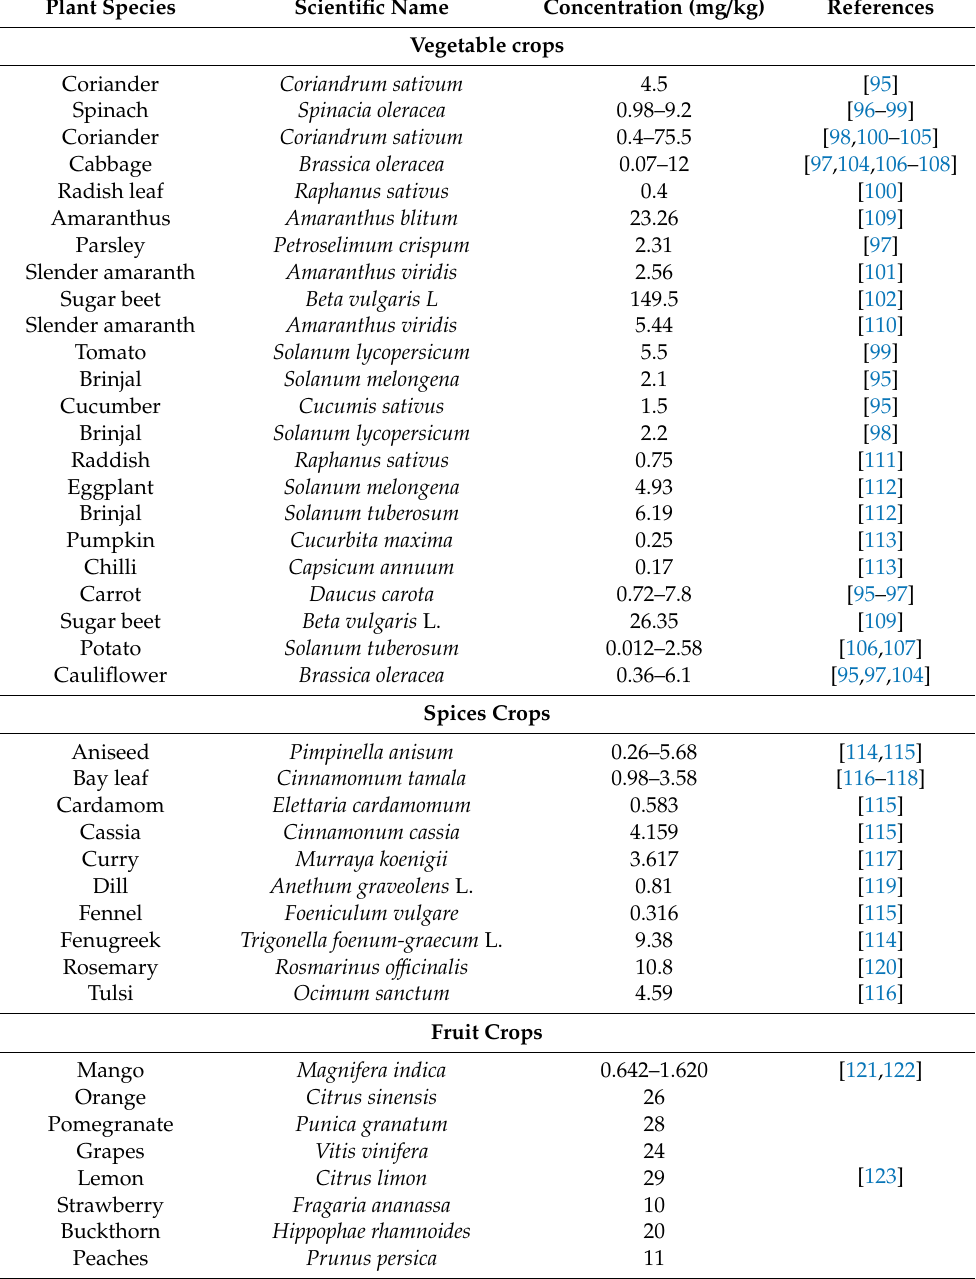
Table 3. Details for the average lead contents in di ff erent crop